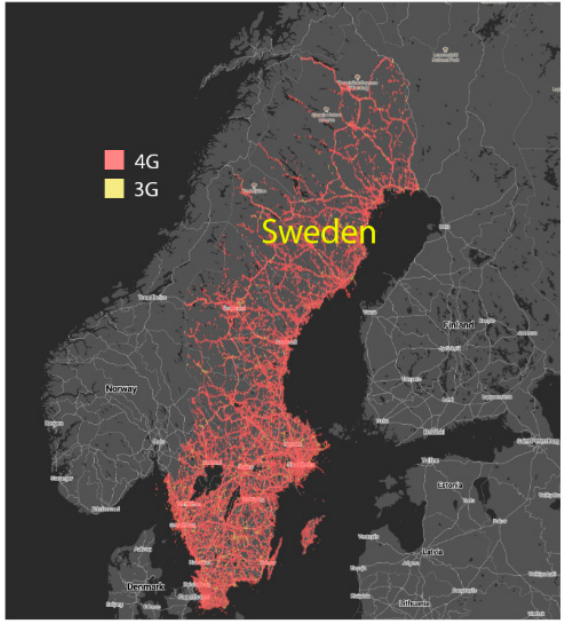
Figure 1. Sweden is a country with a dense grid of mobile phone masts. The map illustrates 4G (red) and 3G (yellow) mobile technology coverage in Sweden provided by Telia. Image reproduced with permission from www.tutela.com (accessed on 25 September 2020).